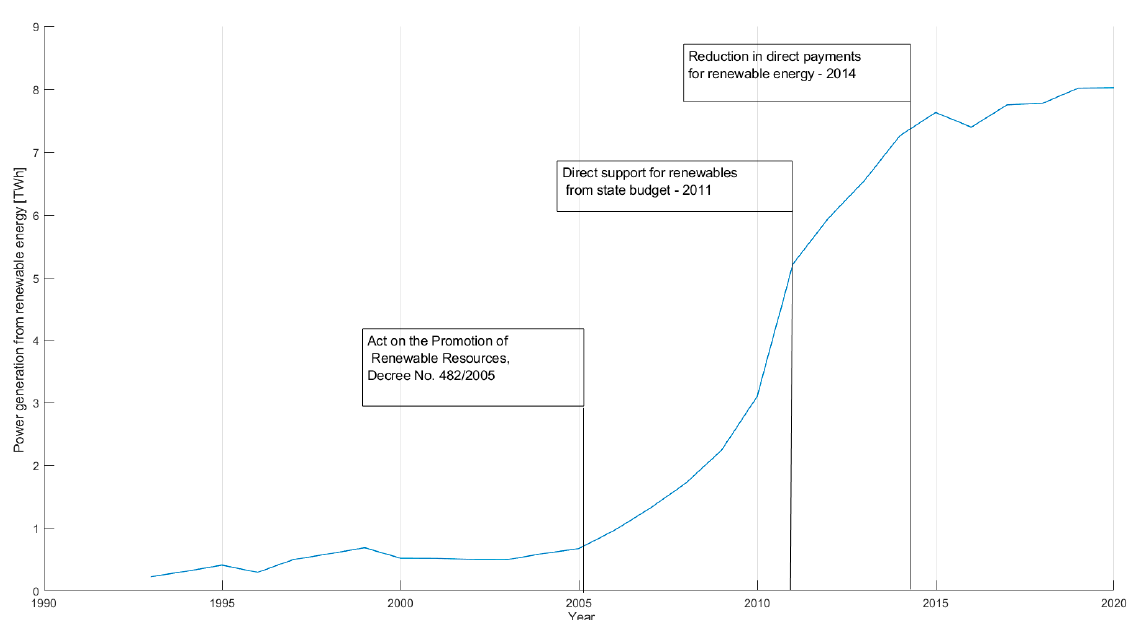
Figure 3. Power generation from renewables in Czech Republic.